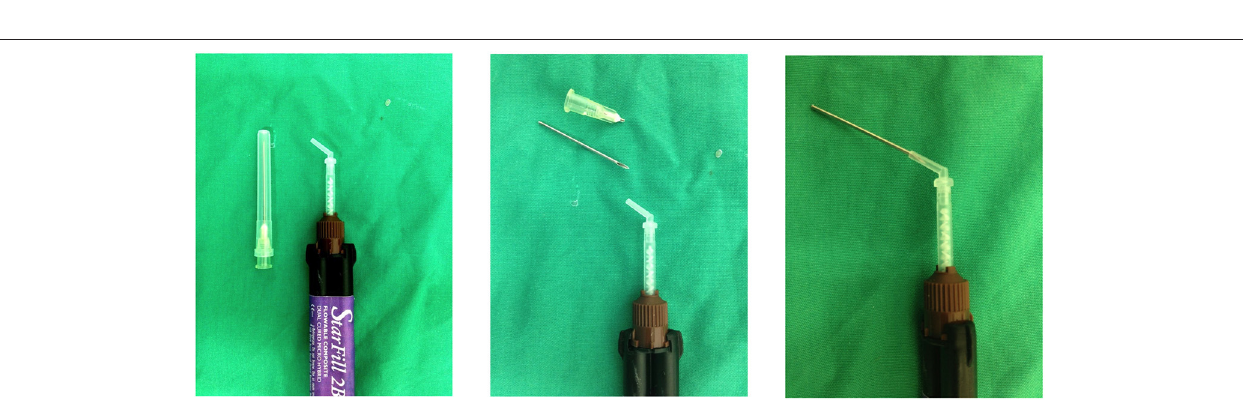
FIGURE 2 | Oroscopic image showing preparation of mesial and distal infundibula of a Triadan 109 tooth prior to restoration. Left , before and Right after successful cavity preparation.